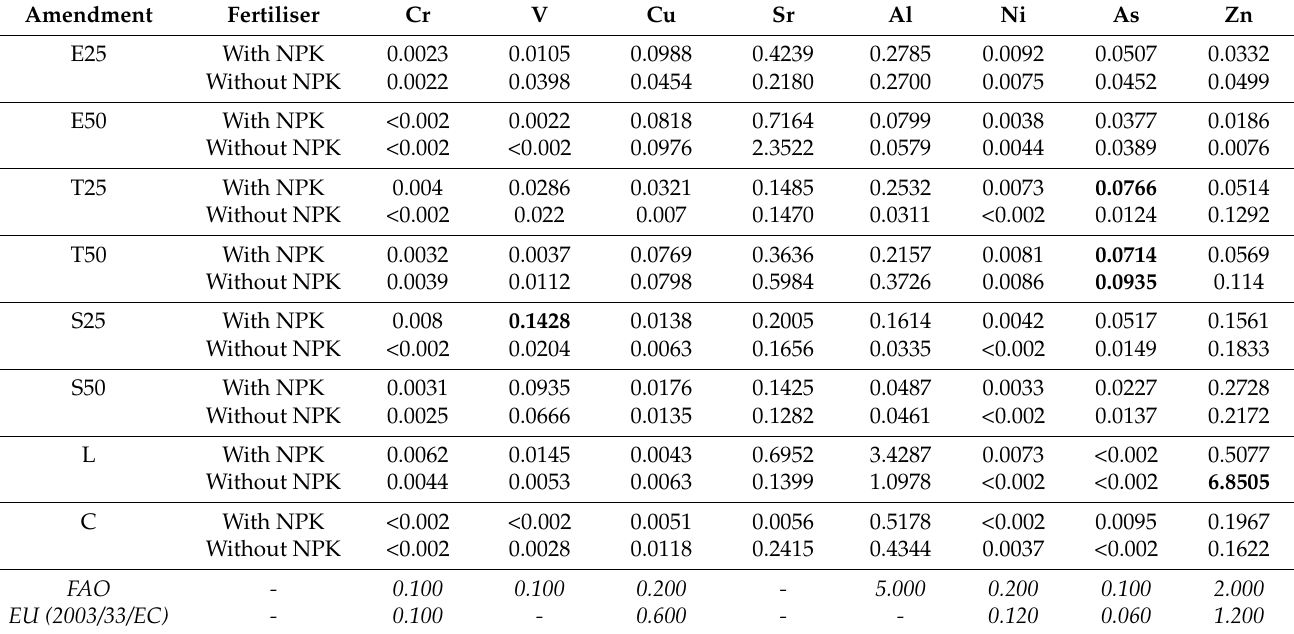
Table 8. Heavy metals in leachates (mg L − 1